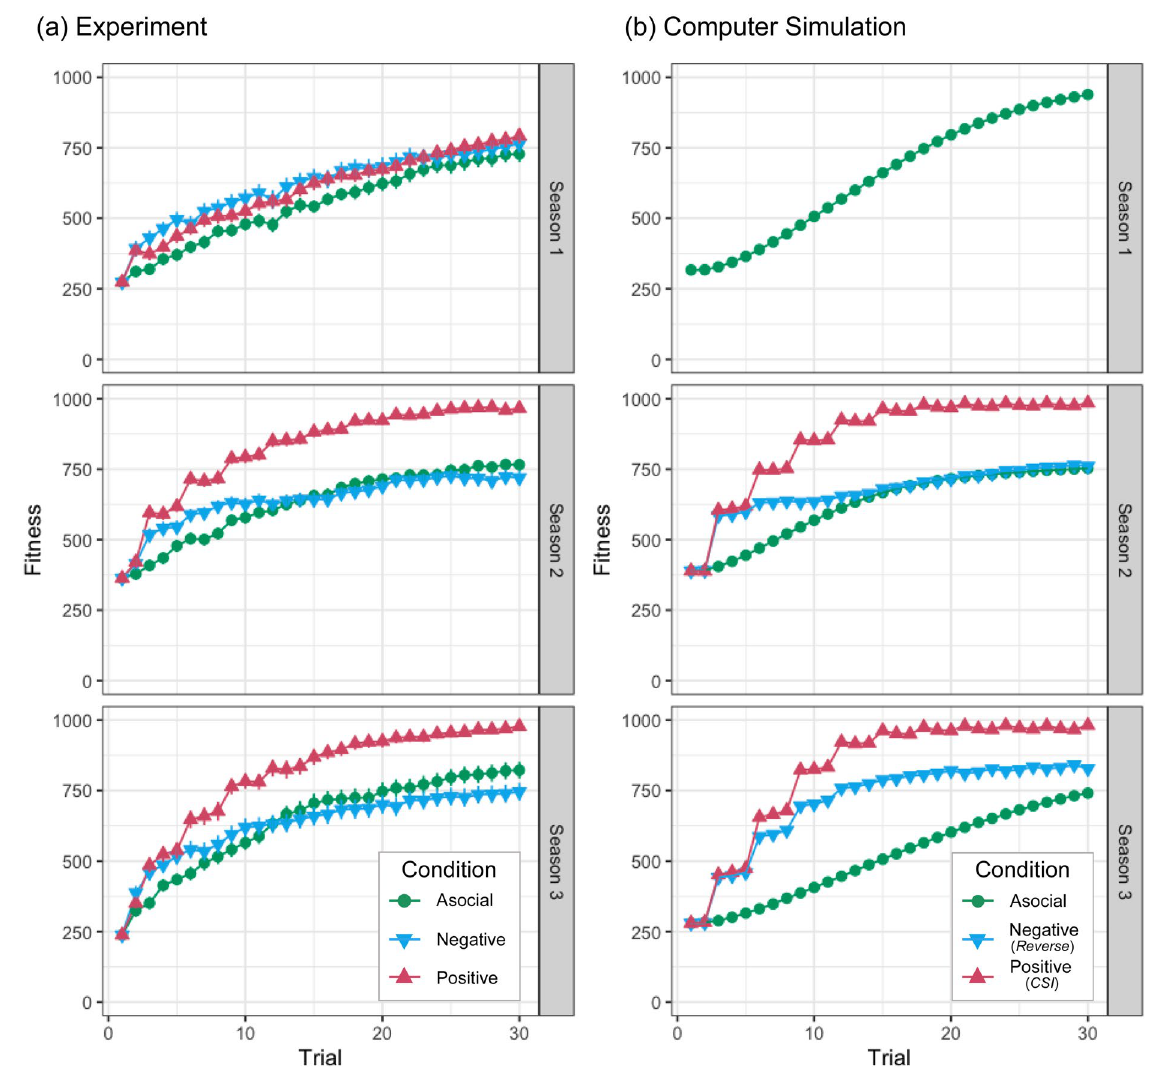
Figure 1. ( a ) Average fitness (performance) of participants’ arrowheads (excluding perception error) against trials. Error bars show standard errors. ( b ) Corresponding results of the computer simulation with the CSI and Reverse social learning algorithms. The rows correspond to seasons both in ( a,b